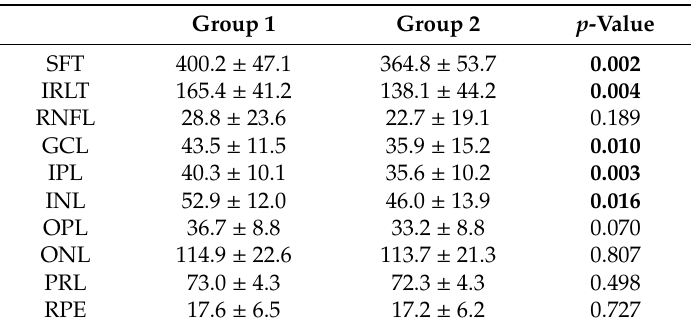
Table 3. Retinal layer thickness in each group at 12 months after surgery.